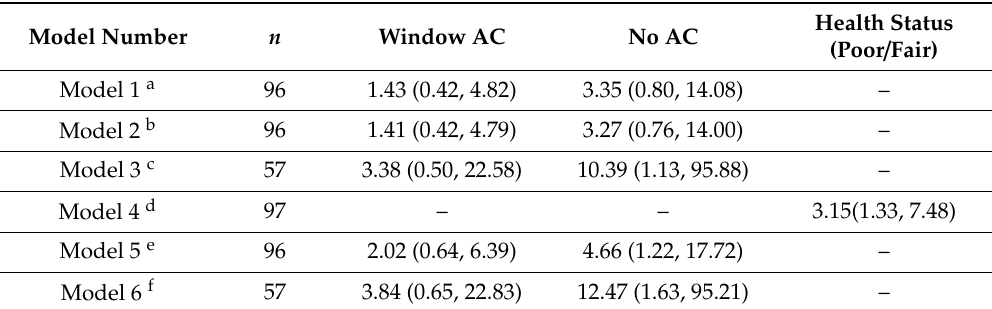
Table 3. Associations (odds ratios and 95% confidence intervals) of heat exhaustion with main exposures AC use and poor / fair health status for the study participants in Detroit, MI,